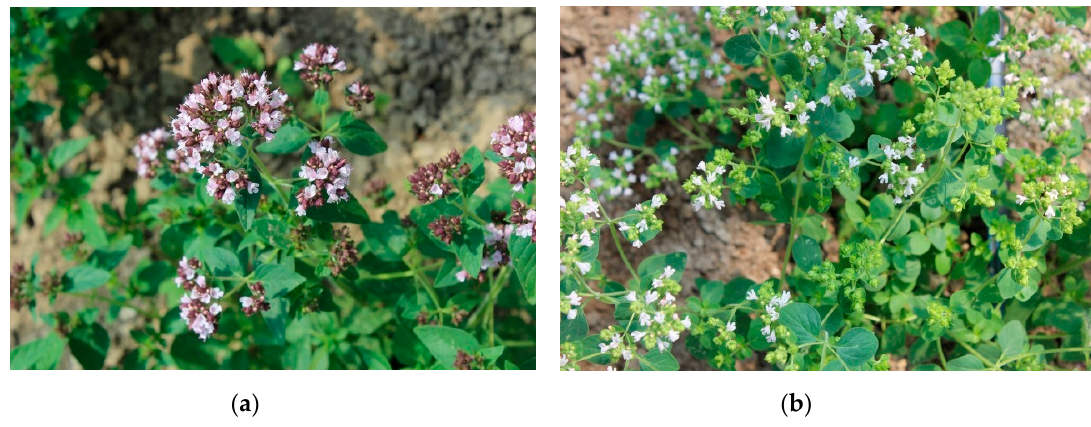
Figure 1. Common oregano ( a ) and Greek oregano ( b ).